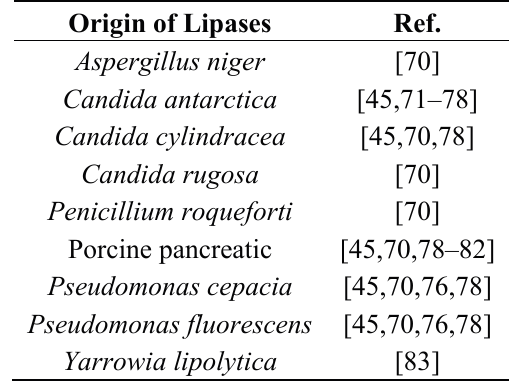
Table 2. Origin of lipases commonly used in the e-ROP of cyclic